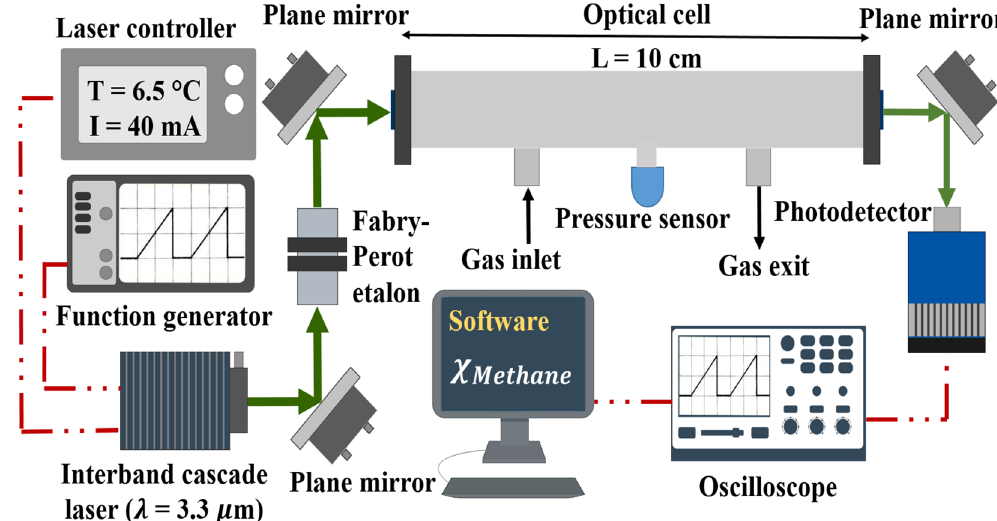
Figure 2. Optical schematic of the methane